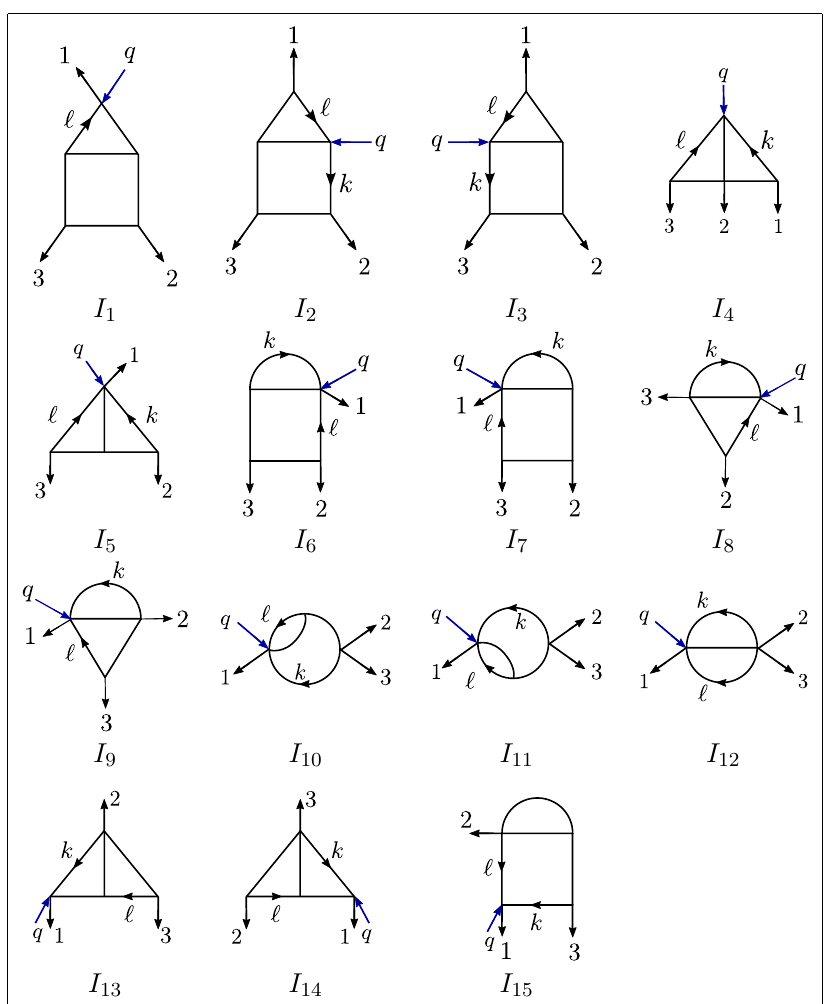
Table 3 . Integral basis for the two-loop form factor F (2)